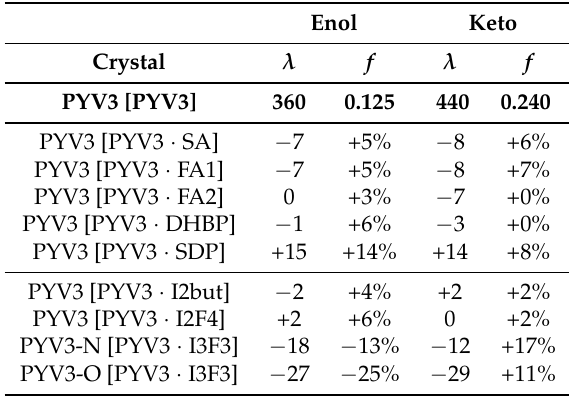
Table 1. RI-CC2/def2-TZVPD first wavelength of excitation ( λ , in nm) and oscillator strength ( f